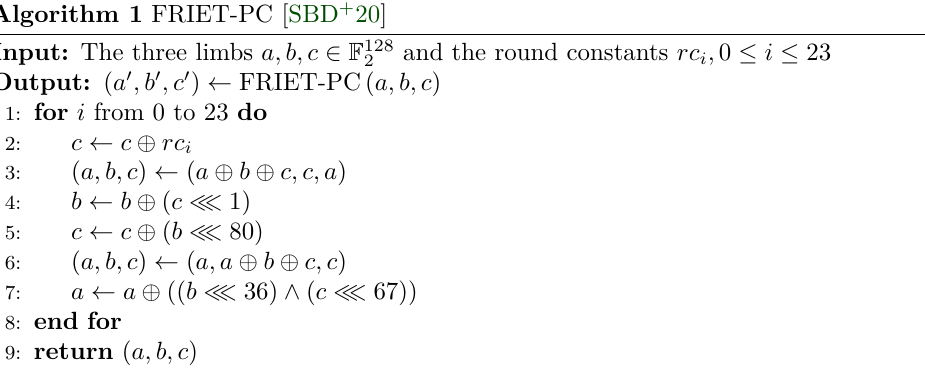
Algorithm 1 FRIET-PC [SBD +